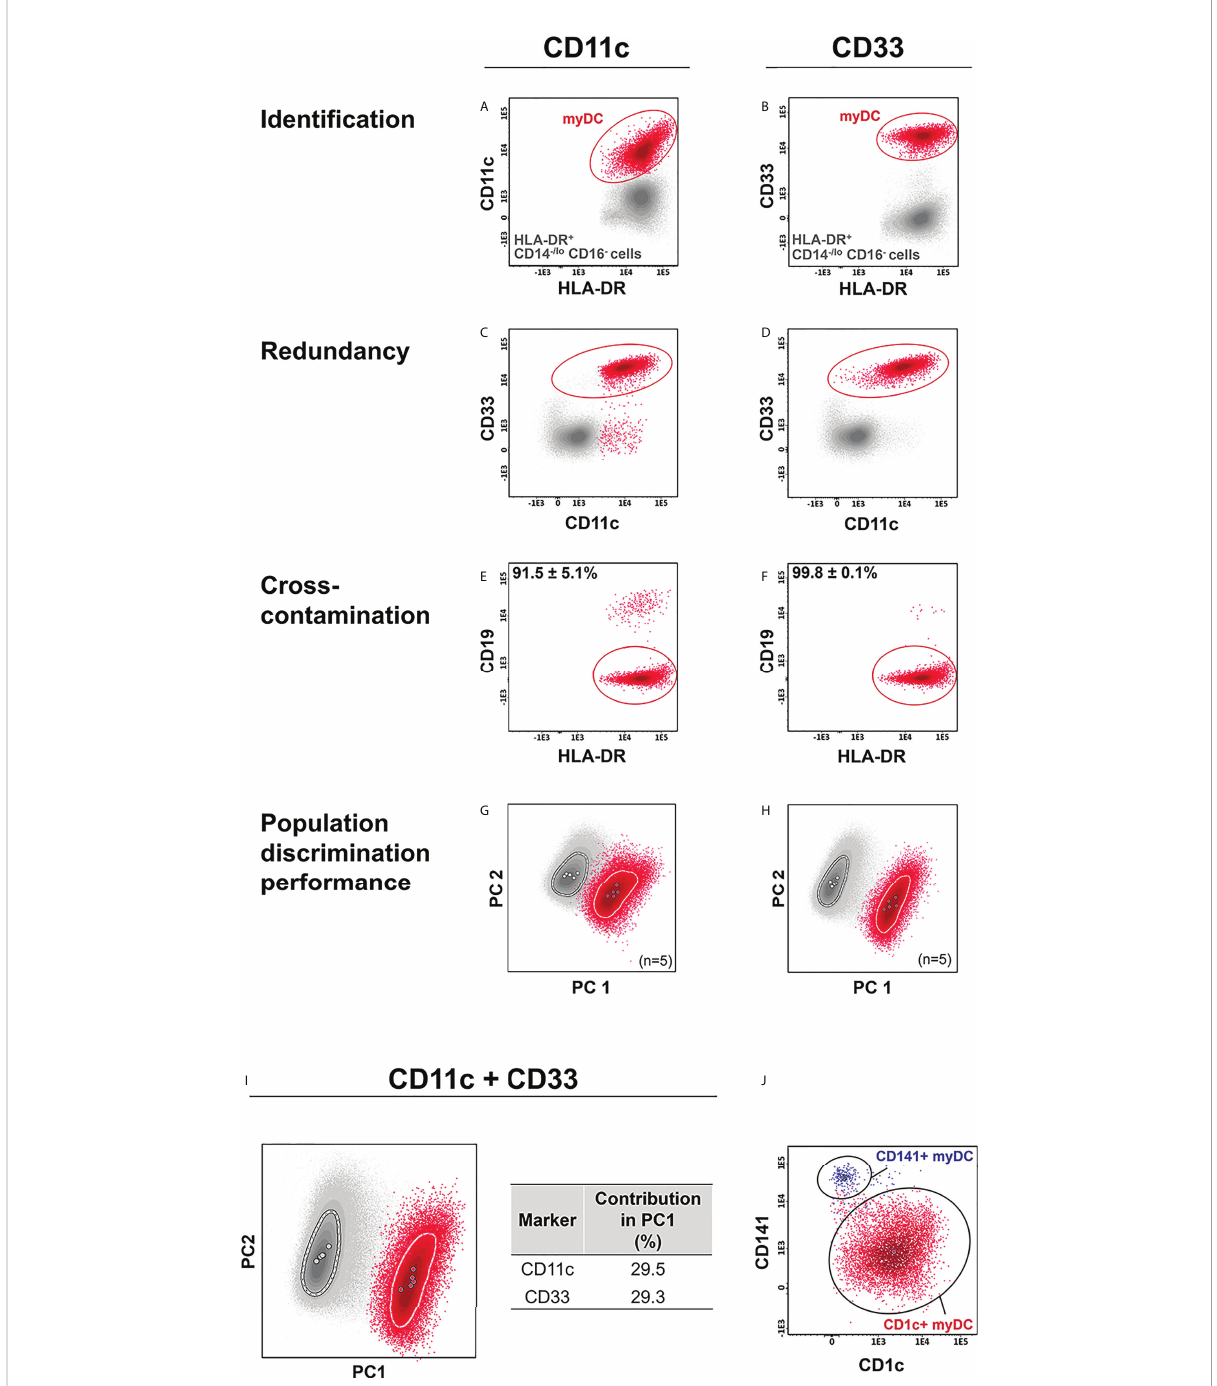
FIGURE 2 Comparison of the performance of CD11c vs. CD33 for identi fi cation of myeloid dendritic cells (myDCs). CD11c and CD33 were individually employed for identi fi cation of myDCs (A, B) within the HLA-DR + CD14 -/lo , CD16 - cell population. Redundancy of each marker vs. the other ( C, D ), and cross-contamination with other cells (E, F) , was evaluated. Marker performance for identi fi cation of myDCs vs. other HLA-DR + CD14 -/lo , CD16 - cells was determined using principal component (PC) analysis (PCA) in the context of cross-staining with CD14, CD16, CD45, HLA-DR for the individual markers (G, H) and in the combination of all markers (I) . The contribution of CD11c and CD33 for the discrimination of the two populations is depicted in the table. (J) shows a representative example of CD1c + myDCs and CD141 + myDCs subsetting within the myDC population, previously identi fi ed based on expression of CD33. Solid circles in all principal component plots represent median values for the parameters evaluated and dotted lines depict the fi rst standard deviation for each population identi fi ed. myDC, myeloid dendritic cells; PC, principal